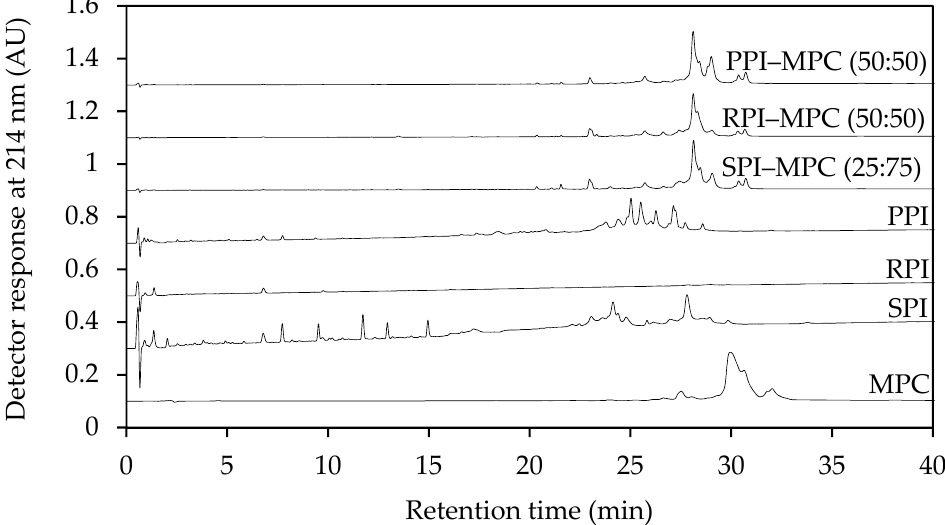
Figure 1. Reverse-phase ultra-performance liquid chromatography profiles of the blends of soy (SPI), rice (RPI) and pea protein isolate (PPI) with milk protein concentrate (MPC) dissolved in 0.1% ( v / v ) trifluoroacetic acid.